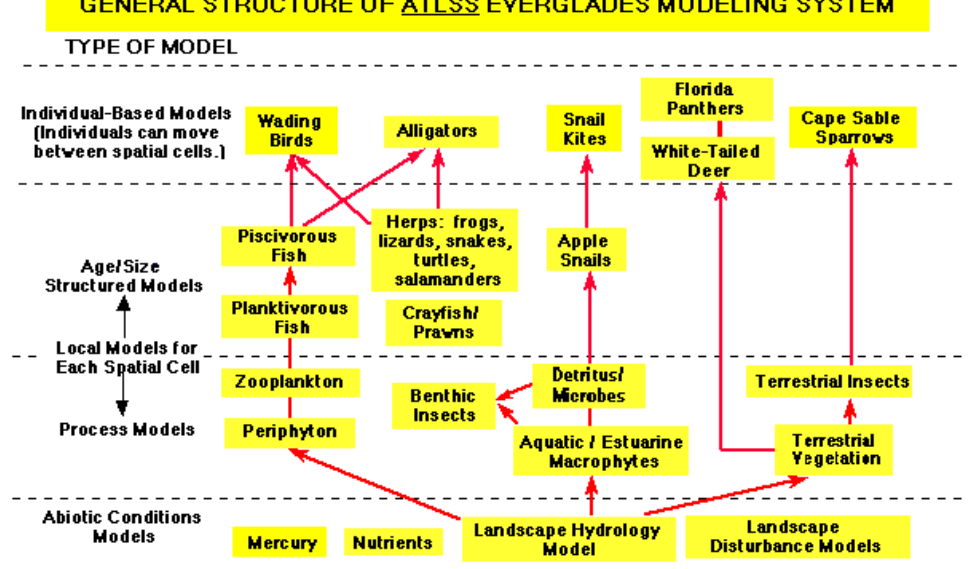
FIGURE 8. Overview of the different modelling topics and model types used in the ATLSS project (from http://www.atlss.org/